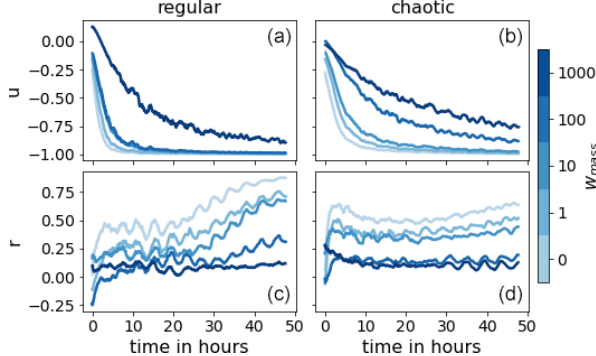
Figure 11. Correlation of the different weighting (blue colors) be- tween the bias of h and the bias of u (a, b) and r (c, d) for the regular (a, c) and the chaotic (b, d)